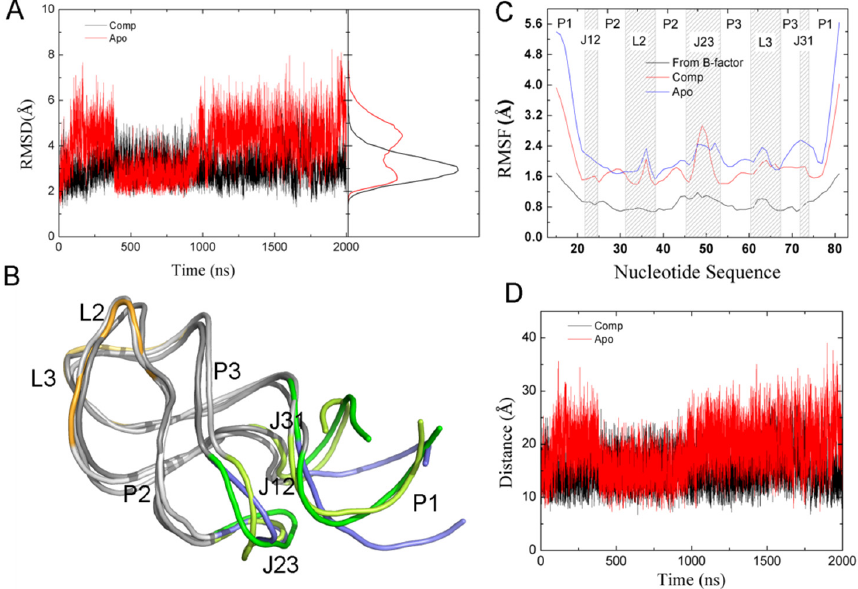
Figure 5. ( A ) The RMSDs and their distribution calculated on P, O3 ′ , O5 ′ , C3 ′ , C4 ′ , and C5 ′ atoms of the nucleotides of GR(C74U) relative to their starting structures. ( B ) The superimposition of two representative structures from Apo-GR(C74U) and one from the complex. All structures are shown in new cartoon representation. The P1J23 regions are shown in different colors. The open and closed conformations of Apo-GR(C74U) are in blue and yellow, while they are in green for the complex. ( C ) Root-mean-square fluctuations (RMSFs) for the P, O3 ′ , O5', C3 ′ , C4 ′ , and C5 ′ atoms of the nucleotides labeled in different regions. The experimental RMSFs from the B-factor are also given. ( D ) D1 versus the MD time for GR(C74U).